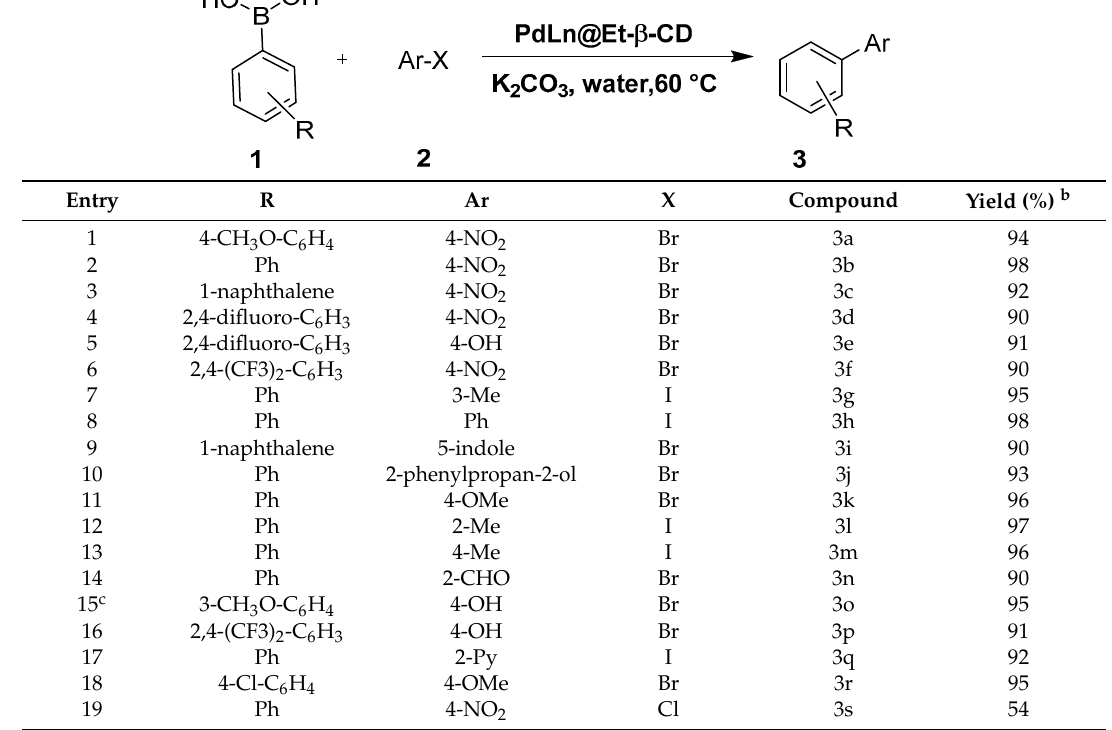
Table 2. Suzuki–coupling between aryl halides and arylboronic acids, catalyzed by PdLn@Et ‐β‐ CD a